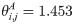
Illustration of differential synchronisation θi, j.The figure shows mean μ(t) and standard errors σ(t) across 100 trials in a pair of voxels i and j. The left pane shows experimental condition A, the right pane condition B. The two voxels of condition A appear to be stronger synchronised than those of condition B. This is reflected by a high value of synchronisation in condition A which is θi,jA=1.453 while for B it is only θi,jB=0.108.